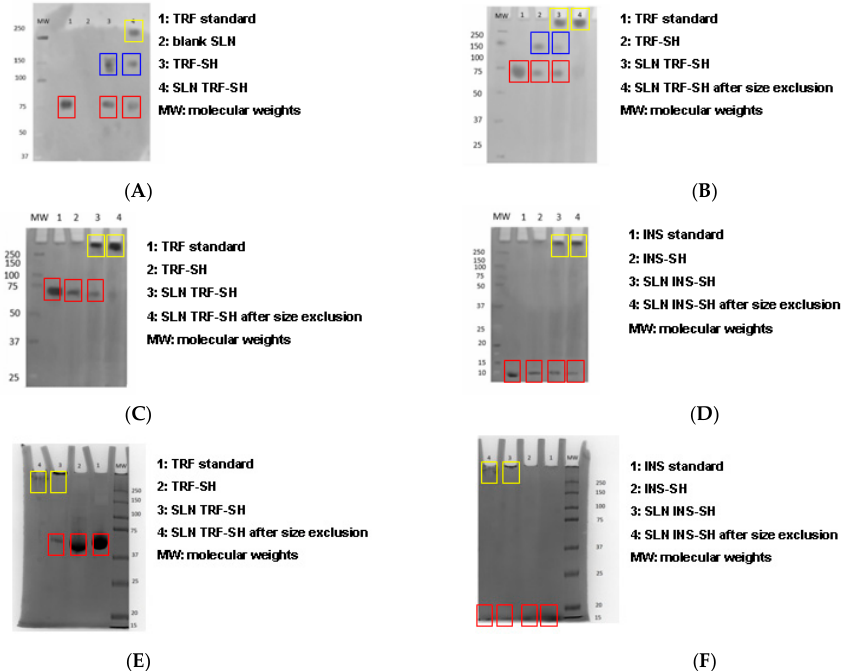
Figure 2. Electrophoresis. Red boxes: free proteins; blue boxes: dimerized proteins; yellow boxes: proteins grafted onto SLNs. ( A ) ST-MBS; 8:1 2-iminothiolane/TRF molar ratio; ( B ) ST-MBS; 4:1 2-iminothiolane/TRF molar ratio; ( C ) ST-MBS; 2:1 2-iminothiolane/TRF molar ratio; ( D ) ST-MBS; 1:1 2-iminothiolane/INS molar ratio; ( E ) ST-PEG-MBS; 2:1 2-iminothiolane/TRF molar ratio; ( F ) ST-PEG-MBS; 1:1 2-iminothiolane/INS molar ratio.